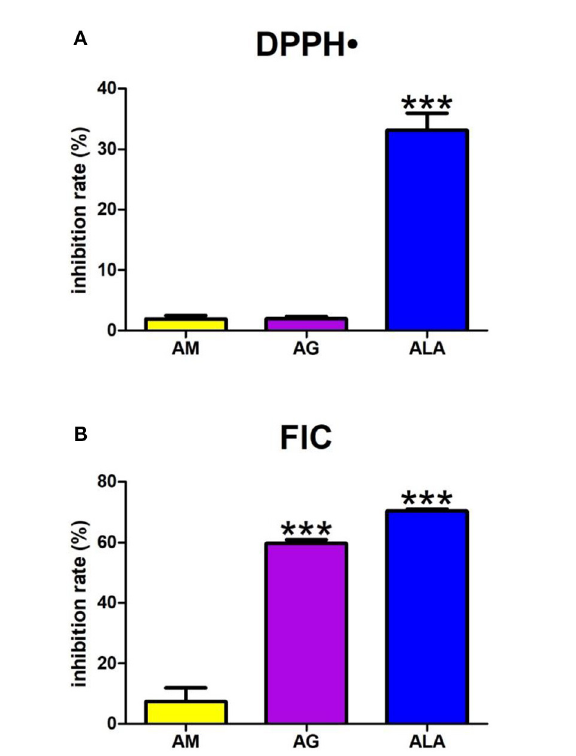
FIGURE4 Antioxidant capacity: 2,2-diphenyl-1-picrylhydrazyl radical (DPPH • ) reducing (A) as well as ferrous iron chelating (FIC) (B) by agomelatine and other additives. AG, aminoguanidine; ALA, α